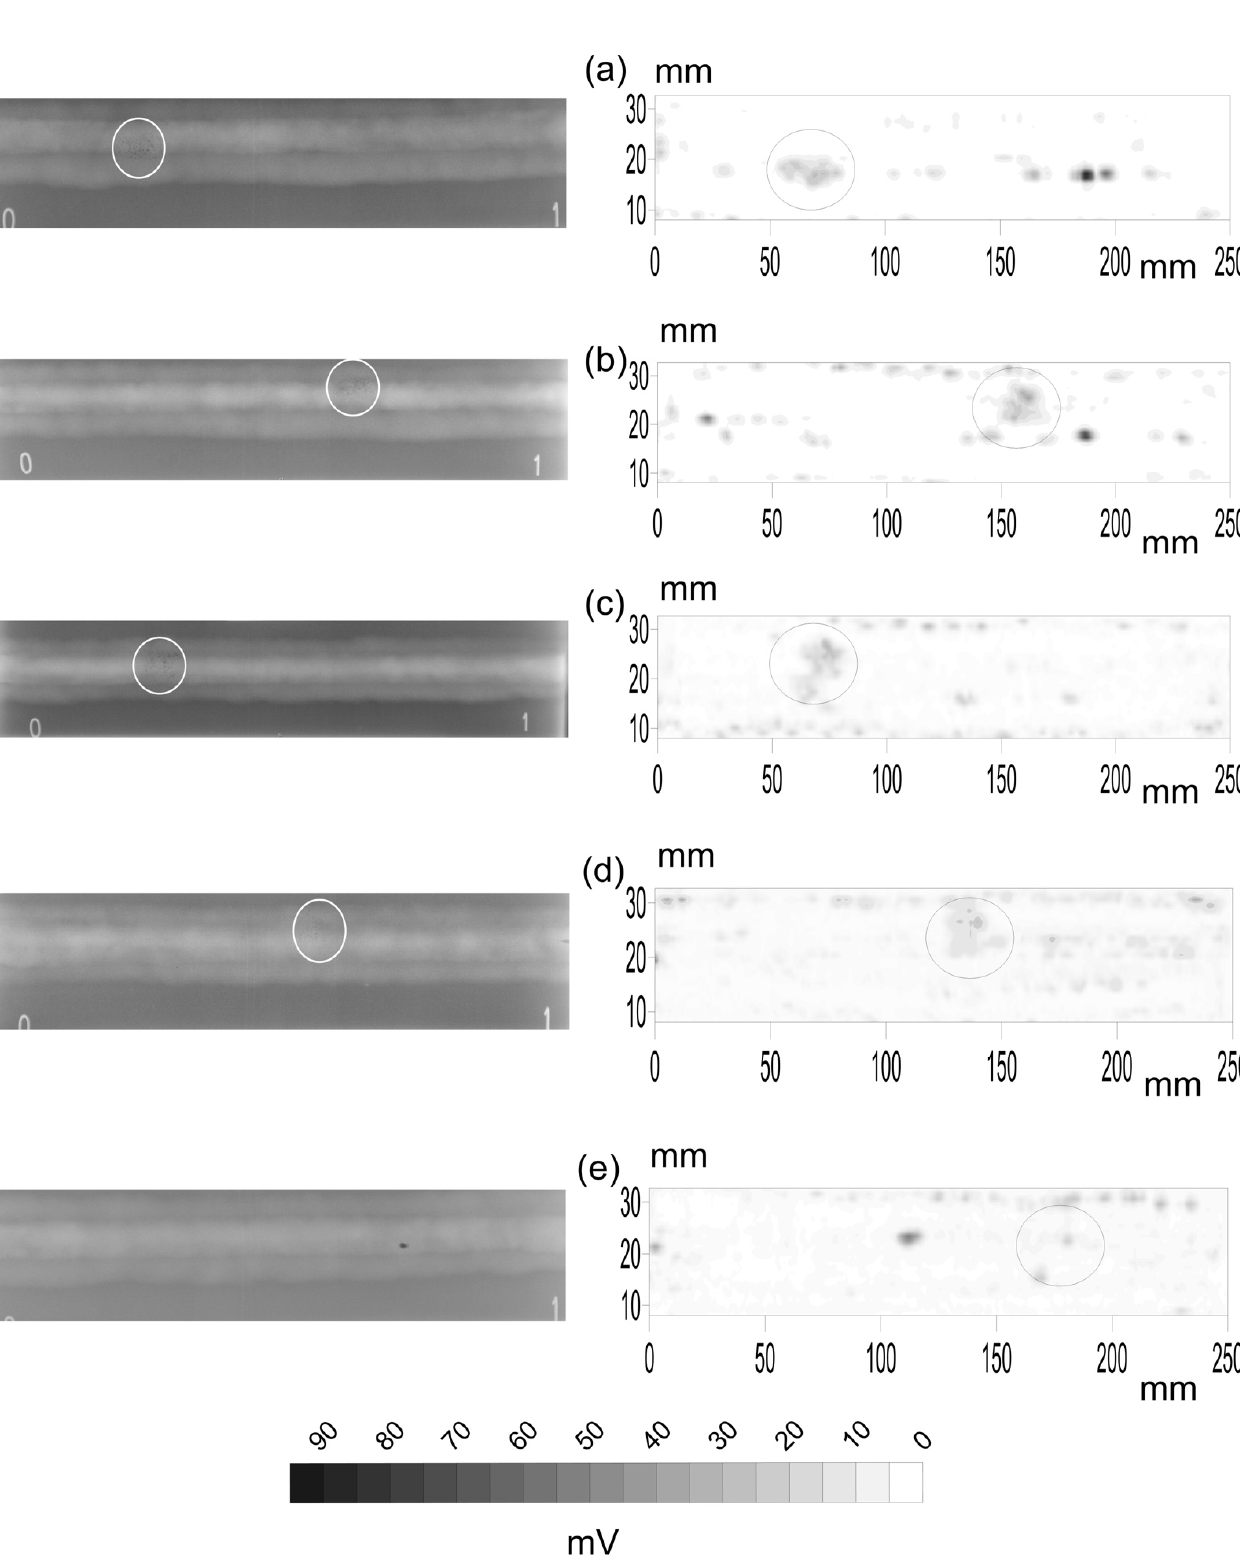
Figure 4. X-ray ( left ) and phased array inspection ( right ) of five specimens, ( a – e ), with pores. Circles point out the coincident pores. The length of the specimen is 250 mm and their width is 30 mm with the axis of the weldment in the middle. The small numbers 0 and 1 in the X-rays images were added when inspected.